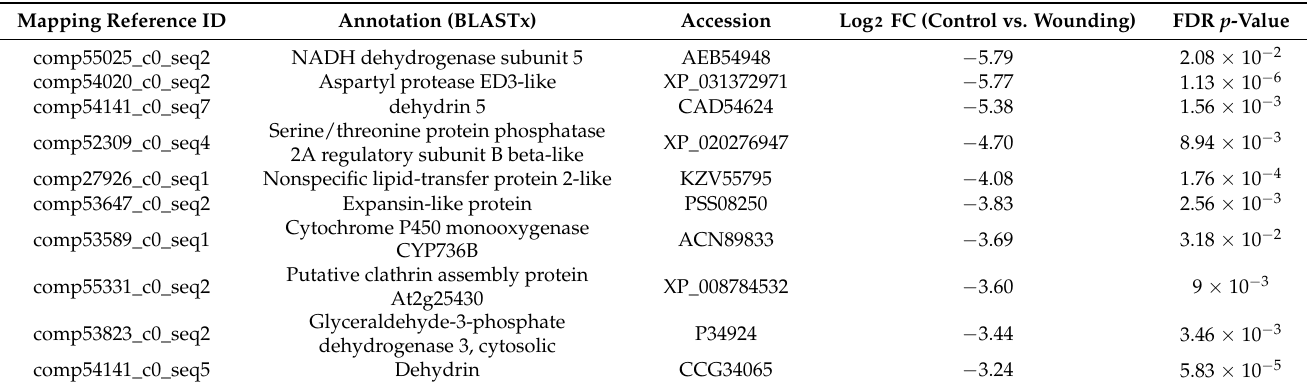
Table 6. Ten most downregulated transcripts after wounding. Table 3. Eleven (10 annotated) most upregulated transcripts after inoculation (compared to control).